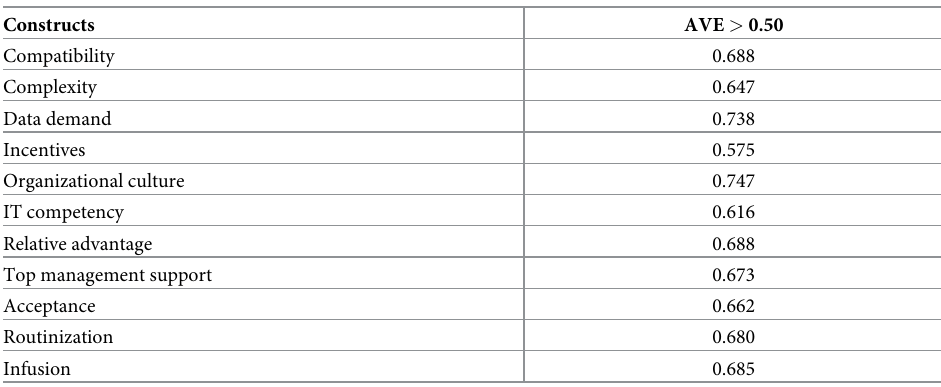
Table 7. Results for convergent validity